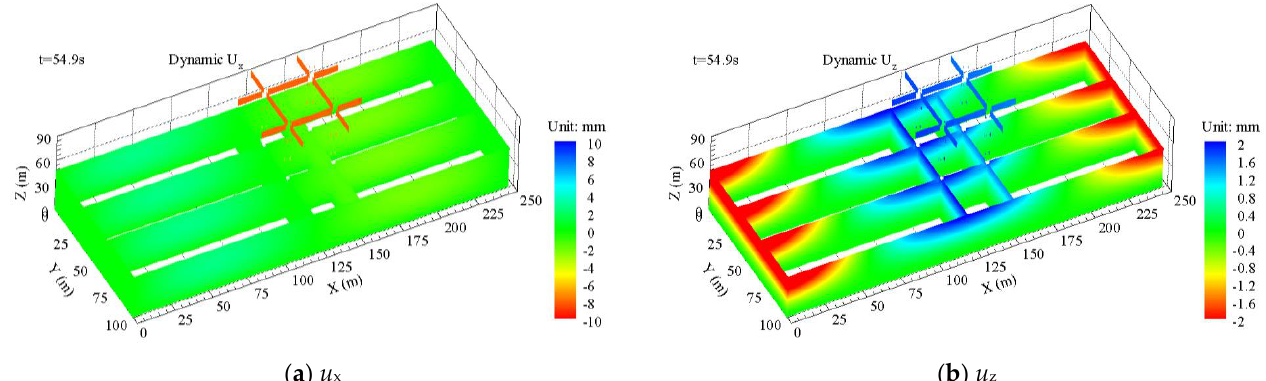
Figure 15. Distribution of the wave-induced dynamic displacement in the x and z directions in the jack-up platform and its seabed foundation when a wave trough reaches the platform at t = 54.9 s ( H = 5 m, d = 50 m, T = 15 s).